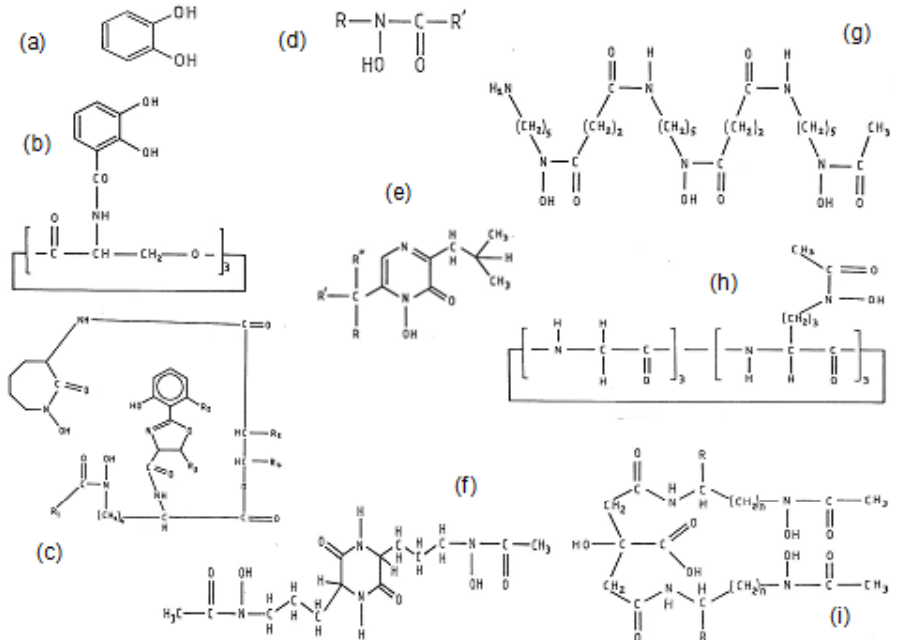
Figure 2. The chemical structure of different microbial siderophores. Many bacteria species produce ( a ) catechol structure-based siderophores such as ( b ) enterobactin. Many fungal species produce ( d ) hydroxamate-based structures such as ( g ) deferoxamine, ( h ) ferrichrome, ( i ) citrate hydroxamate and ( f ) rhodotorulic acid. Siderophores with different chelating structures include ( c ) mycobactin and ( e ) aspergillic acid. For more siderophore structures see references 13 and 14.